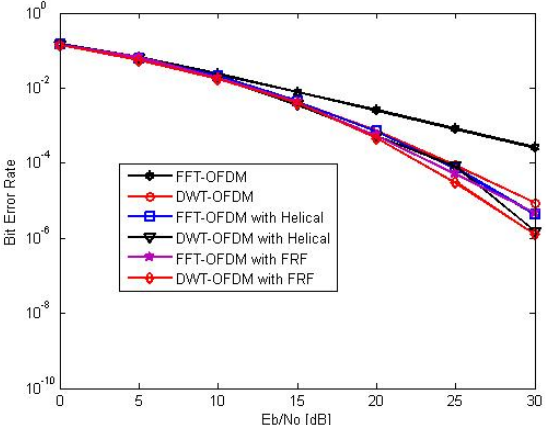
Figure 12. BER performance for the FFT − OFDM and DWT − OFDM systems over SUI-6 channel.